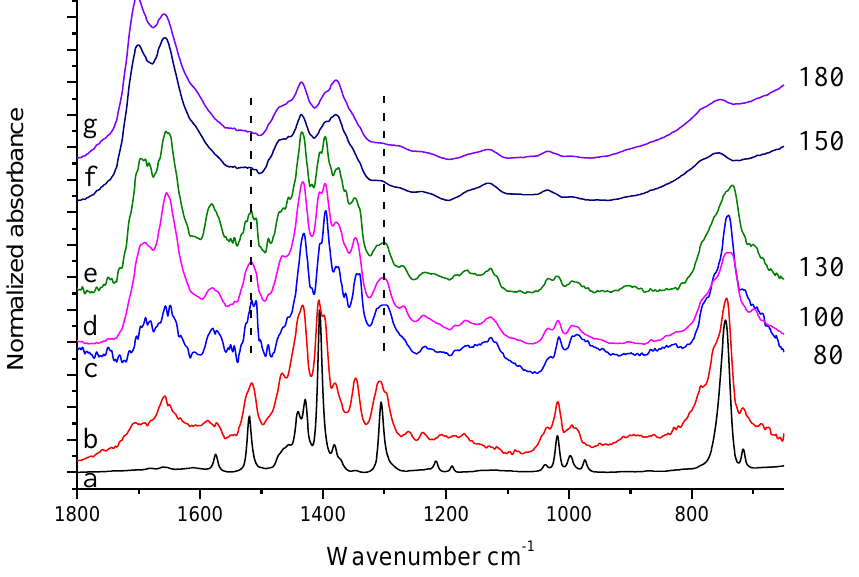
Figure 10. Experimental spectra of: ( a ) TMP, ( b ) reference spectrum of TMP sample treated in air at 130 °C (residue after evaporation), ( c )–( g ) solid powder of HSAG/TMP mixture in equimolar amount treated at different temperature.